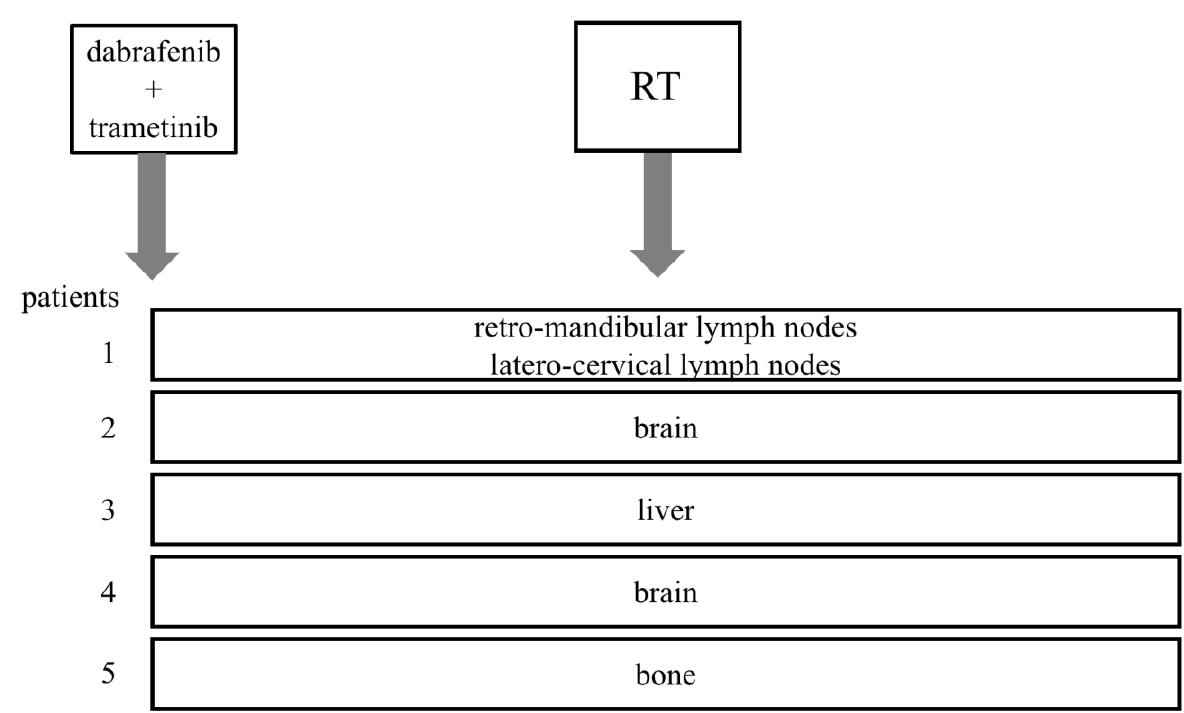
Figure 1. Sites of progression treated with radiotherapy (RT) during treatment with dabrafenib + trametinib. +